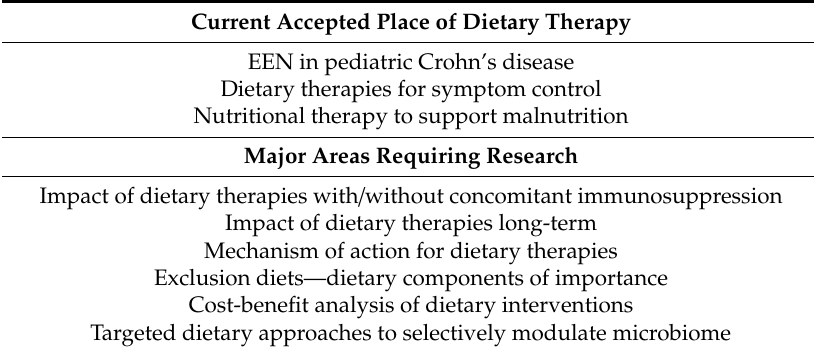
Table 3. Dietary Therapy for IBD: Now and the